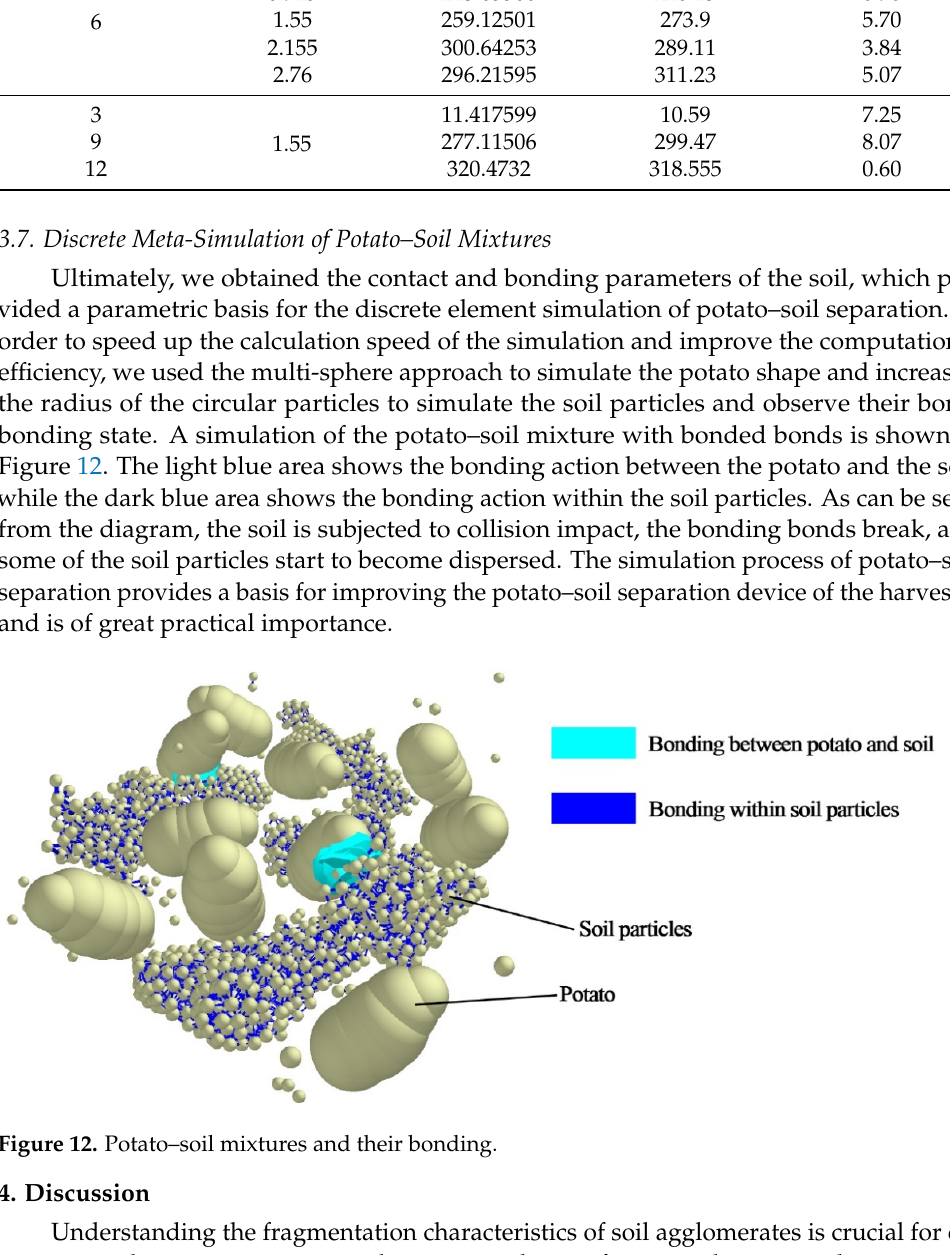
Table 13. Comparison of physical and simulation tests of unconfined compression. Water Content